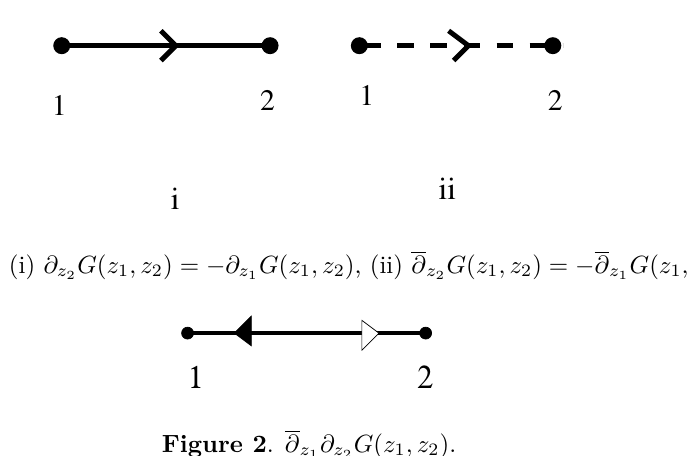
∂ z G ( z 1 , z 2 ) 1 2